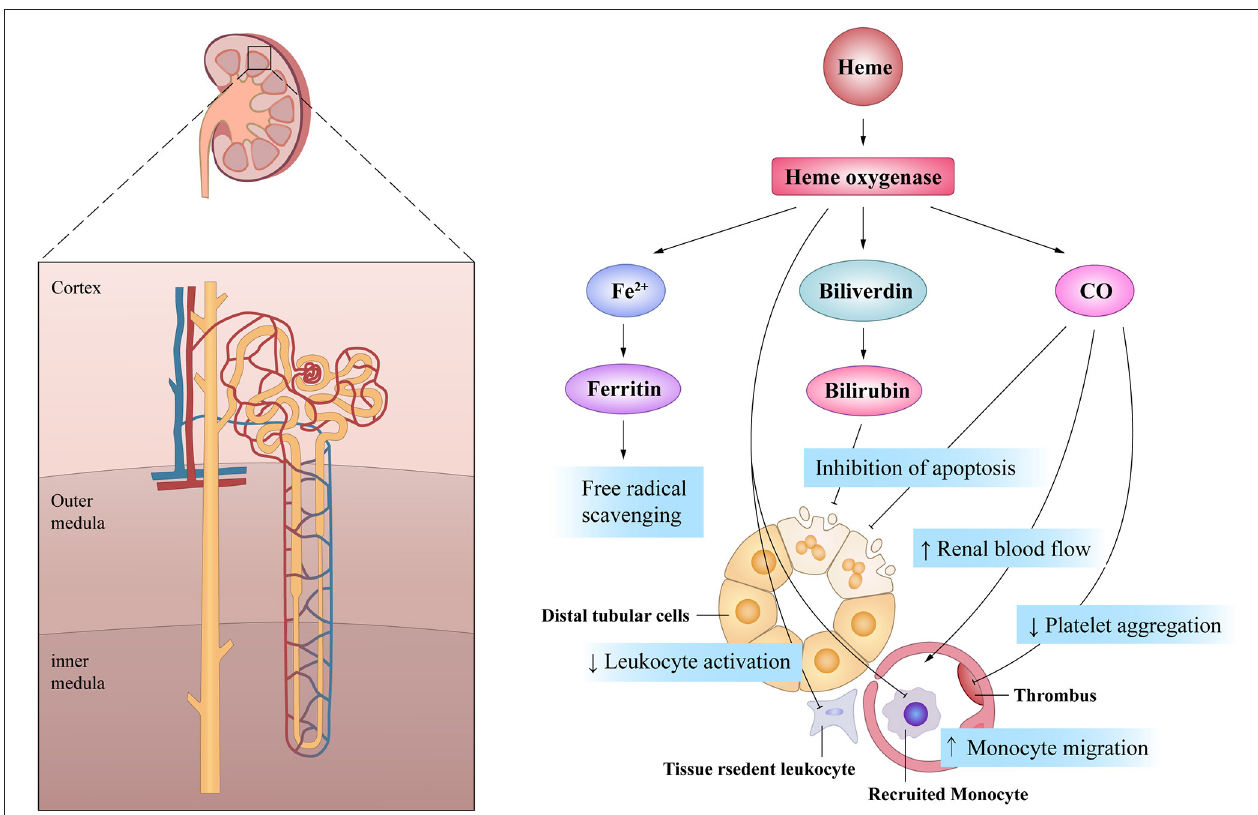
FIGURE 3 | The beneficial actions of HO-1 on renal tubule in acute kidney injury. HO-1 and its products of heme exhibit pleiotropic effects on the cell survival, the inflammatory response and the microcirculation, all of which are of potential importance in mediating its potential protective effects after